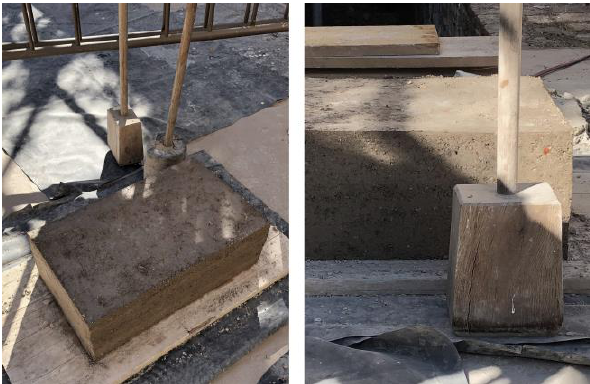
Figure 5. Rammed earth test specimen built in-situ .